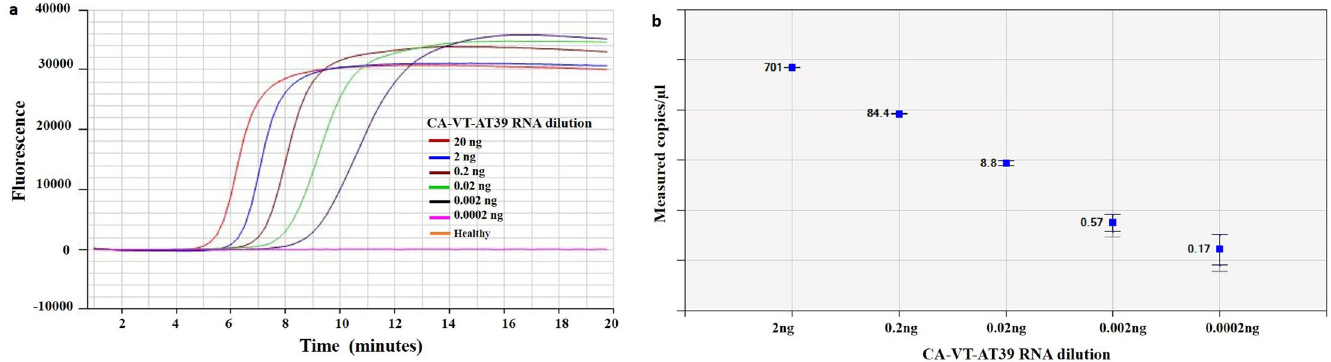
Fig 2. Amplification curve and Linear regression of tenfold serially diluted CA-VT-AT39 infected citrus leaf RNA in RT-LAMP assay and one step RT-ddPCR for a VT strain of Citrus tristeza virus . (a) Amplification curve of healthy citrus tissue RNA and ten-fold serially diluted ranging from 20 ng to 0.0002 ng of CA-VT-AT39 infected citrus leaf tissue RNA in RT-LAMP assay. CA-VT-AT39 RNA detection times were 6:25, 7:10, 8:10, 9:10, 10:35 (min:sec) for 20 ng, 2 ng, 0.2 ng, 0.02 ng, 0.002 ng of RNA respectively. (b) The Pearson correlation coefficient of CA-VT-AT39 RNA the regression curves (y = 0.967x—182.68) is 0.9998. The inner error bars indicate the Poisson 95% confidence interval (CI) and the outer error bars show the total 95% CI of replicates.